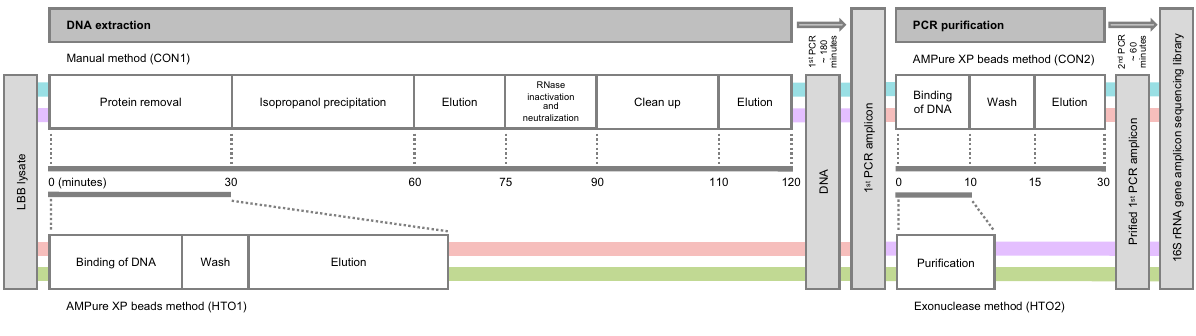
Figure 1. Schematic overview of the methods tested in this study. Experimental procedure for microbiome analysis. For DNA extraction, the AMPure XP bead method (High-throughput option 1, HTO1) and manual method as control (Control 1, CON1) were tested. For the first PCR purification in the library preparation, the exonuclease method (High-throughput option 2, HTO2) and AMPure XP bead method as control (Control 2, CON2) were